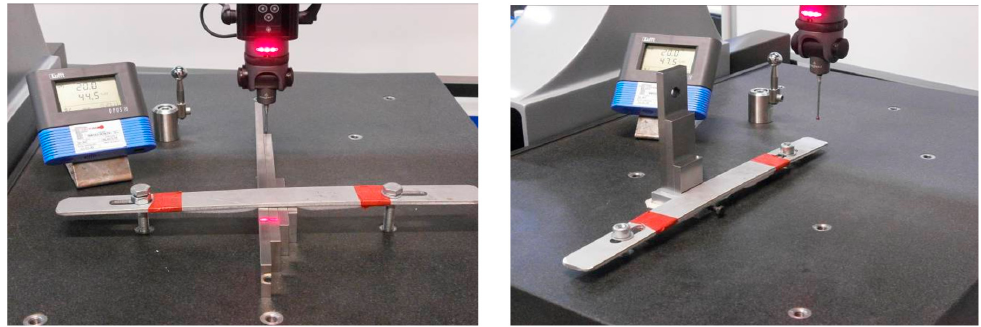
Figure 1. CMM verification by measuring a calibrated gauge step set.